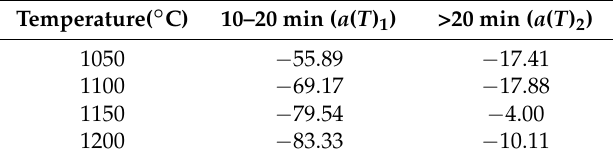
Table 3. Coefficient factors ( a ( T )) for different temperatures and time